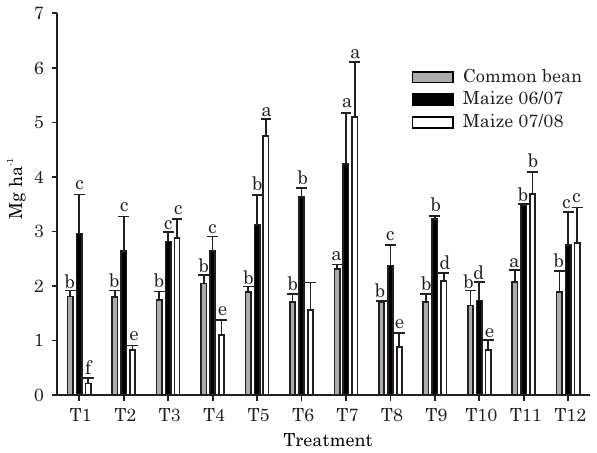
Figure 2. Grain yield of common bean (2005/06) and maize (2006/07 and 2007/08) crops subjected to organic and mineral fertilization. T1 - without application; T2 - 10 m 3 ha -1 PS; T3 - 10 m 3 ha -1 PS+TNF; T4 - 20 m 3 ha -1 PS; T5 - 20 m 3 ha -1 PS+TNF; T6 - 30 m 3 ha -1 PS; T7 - 30 m 3 ha -1 PS+TNF; T8 - 1